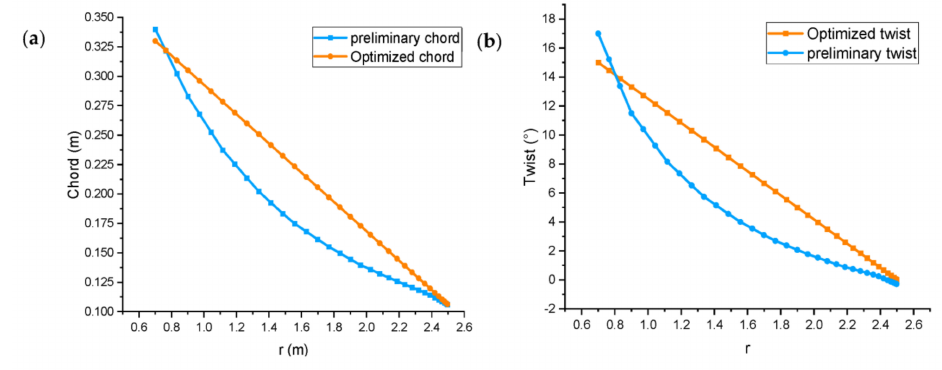
Figure 8. Blade distribution ( a ) chord Length and ( b ) twist